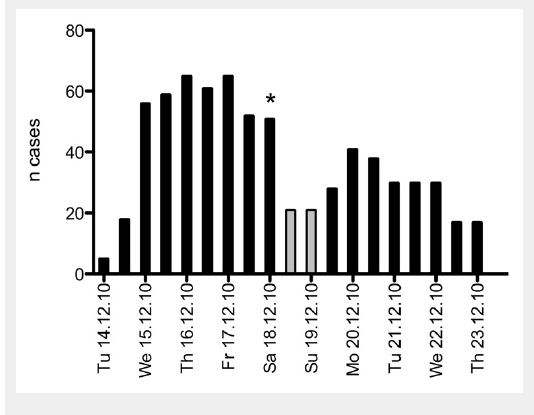
Epidemic curve, representing all cases at infirmary every 12 hours. The 32 patients, who stayed at home after the weekend break, were not included because the exact day of disease onset was not known. The gray bars indicate a 36 hour weekend-leave for healthy recruits. * = hospitalisation of two recruits.